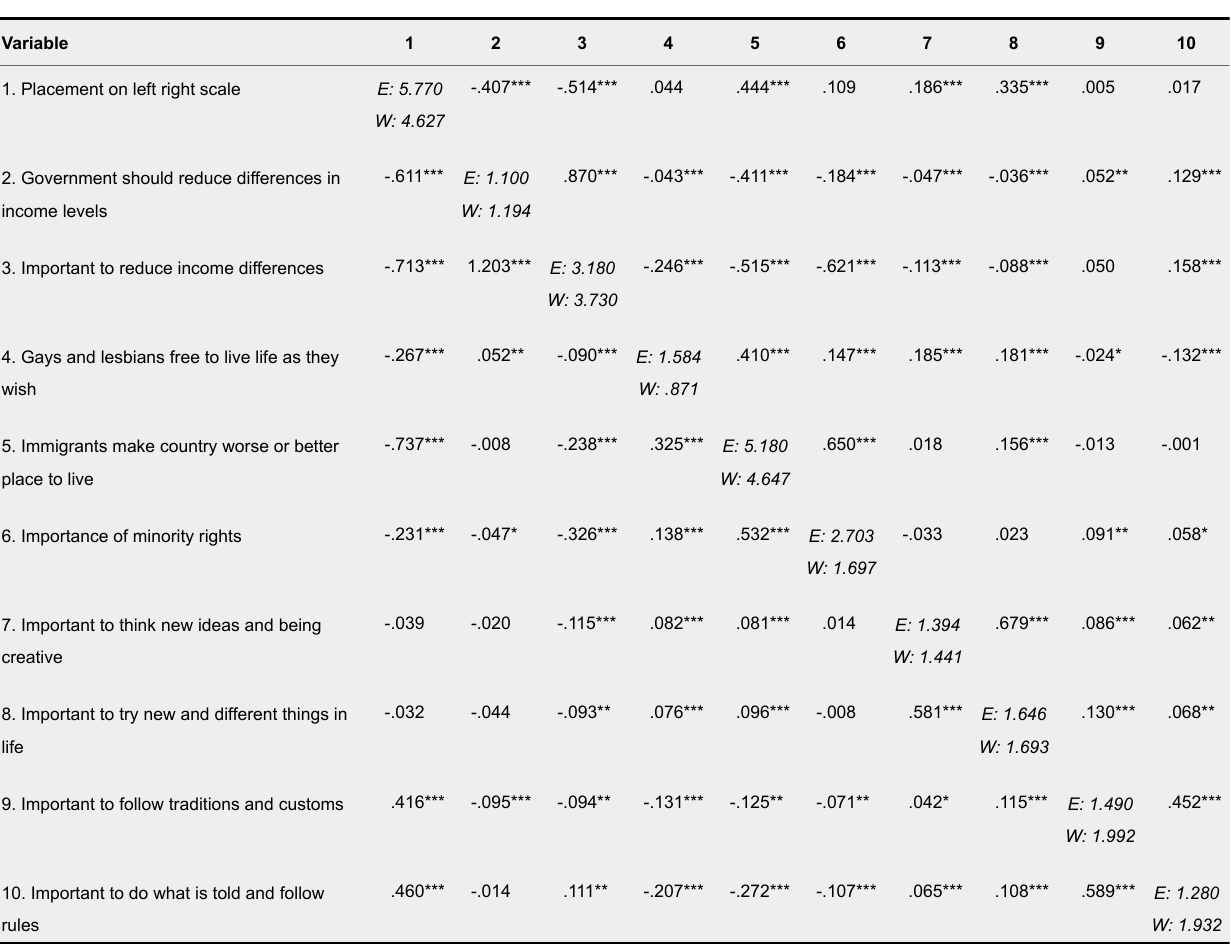
Variances and Covariances of Variables